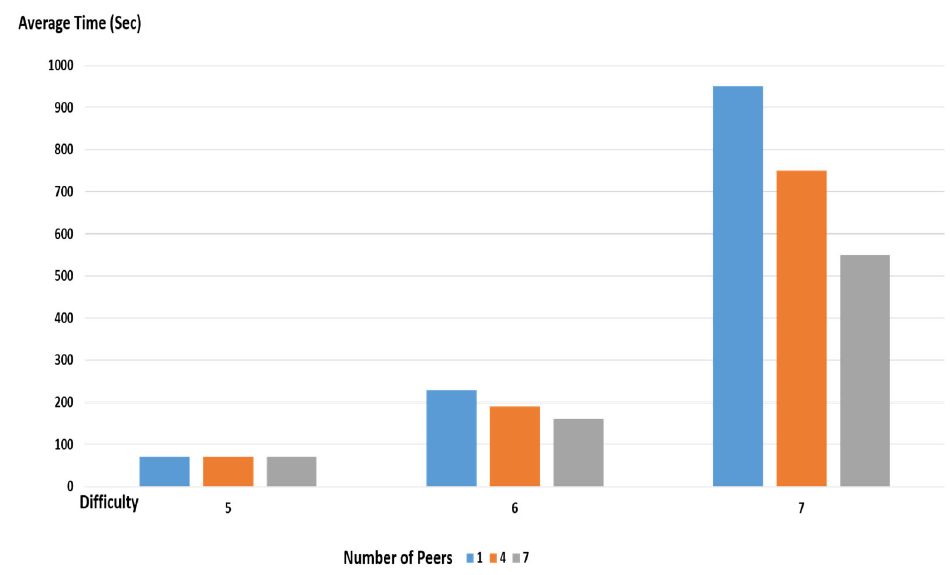
Figure 9. Second scenario results (parallel mining without using PSO step).